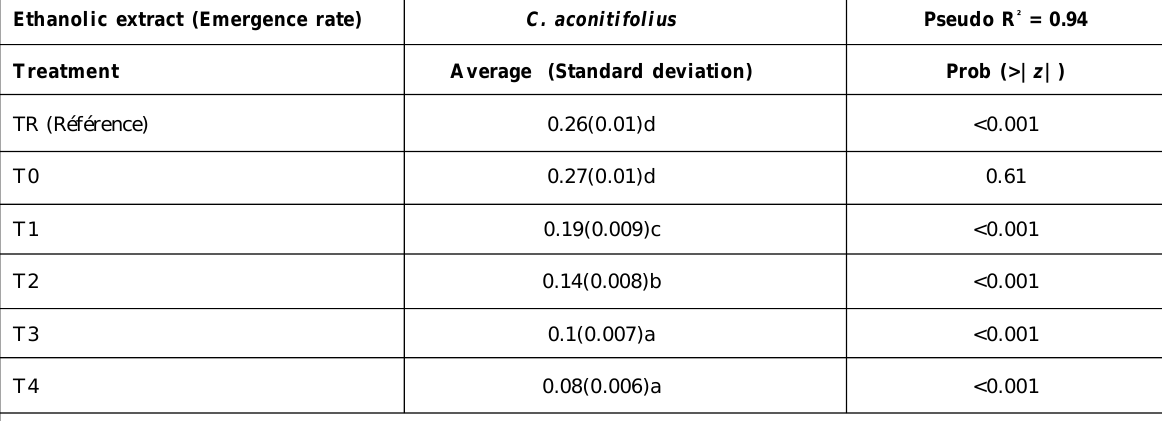
Table 8 : Result of beta regression applied to emergence of C. maculatus under the effect of ethanolic extract of C.